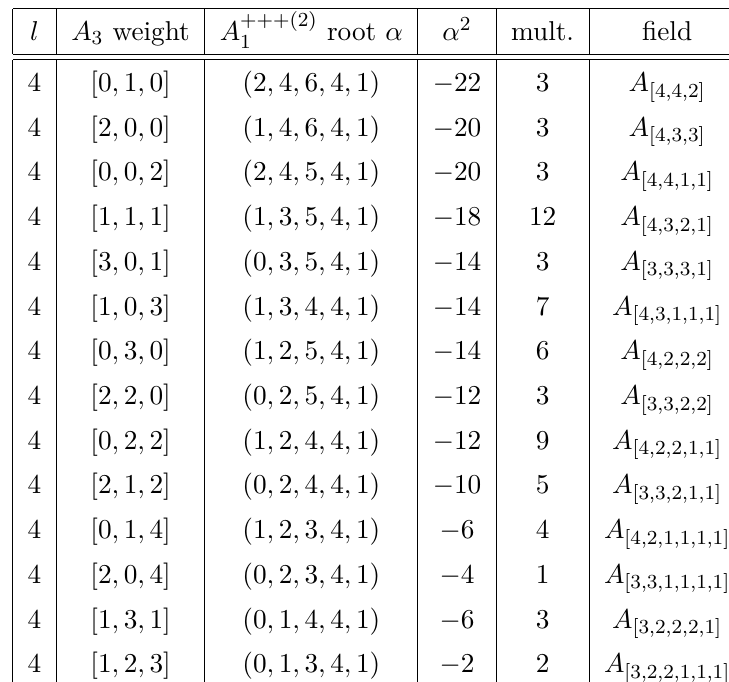
Table 6 . The ‘ 2 representation of A +++